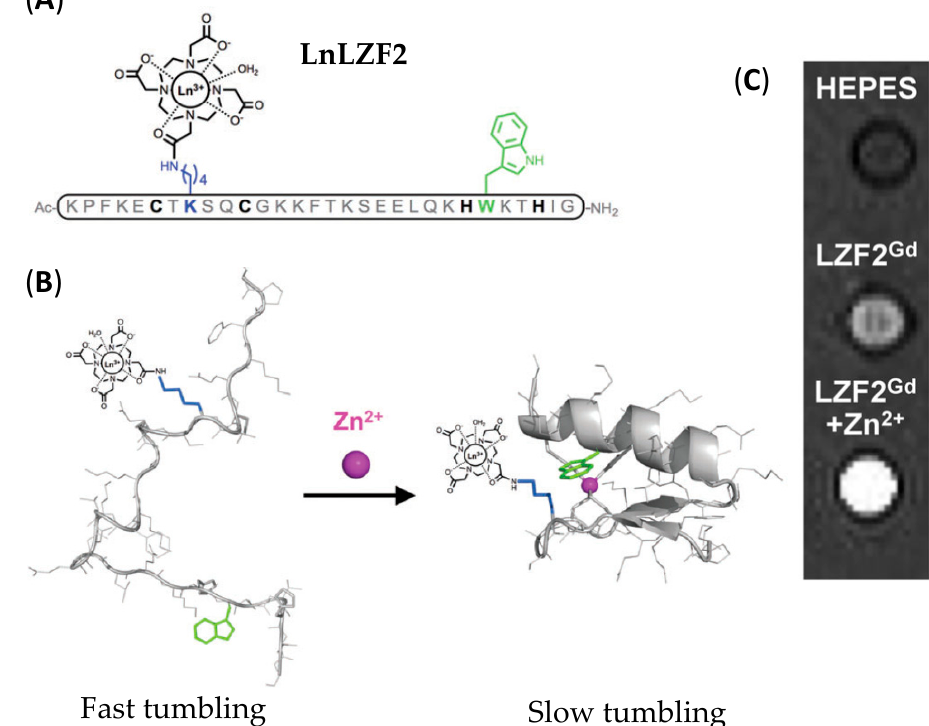
Figure 8. Bioinspired zinc finger peptide and principle for zinc detection by Magnetic resonance imaging (MRI): ( A ) Structure of bioinspired zinc-finger peptide LnLZF2 ; ( B ) Representation of the folding of LnLZF2 upon Zn 2+ binding; ( C ) T 1 -weighted MR images of phantoms containing Zn-free ad Zn-loaded GdLZF2 at 1.5 T. Adapted with permission from Ref [75]; published by The Royal Society of Chemistry, 2018.